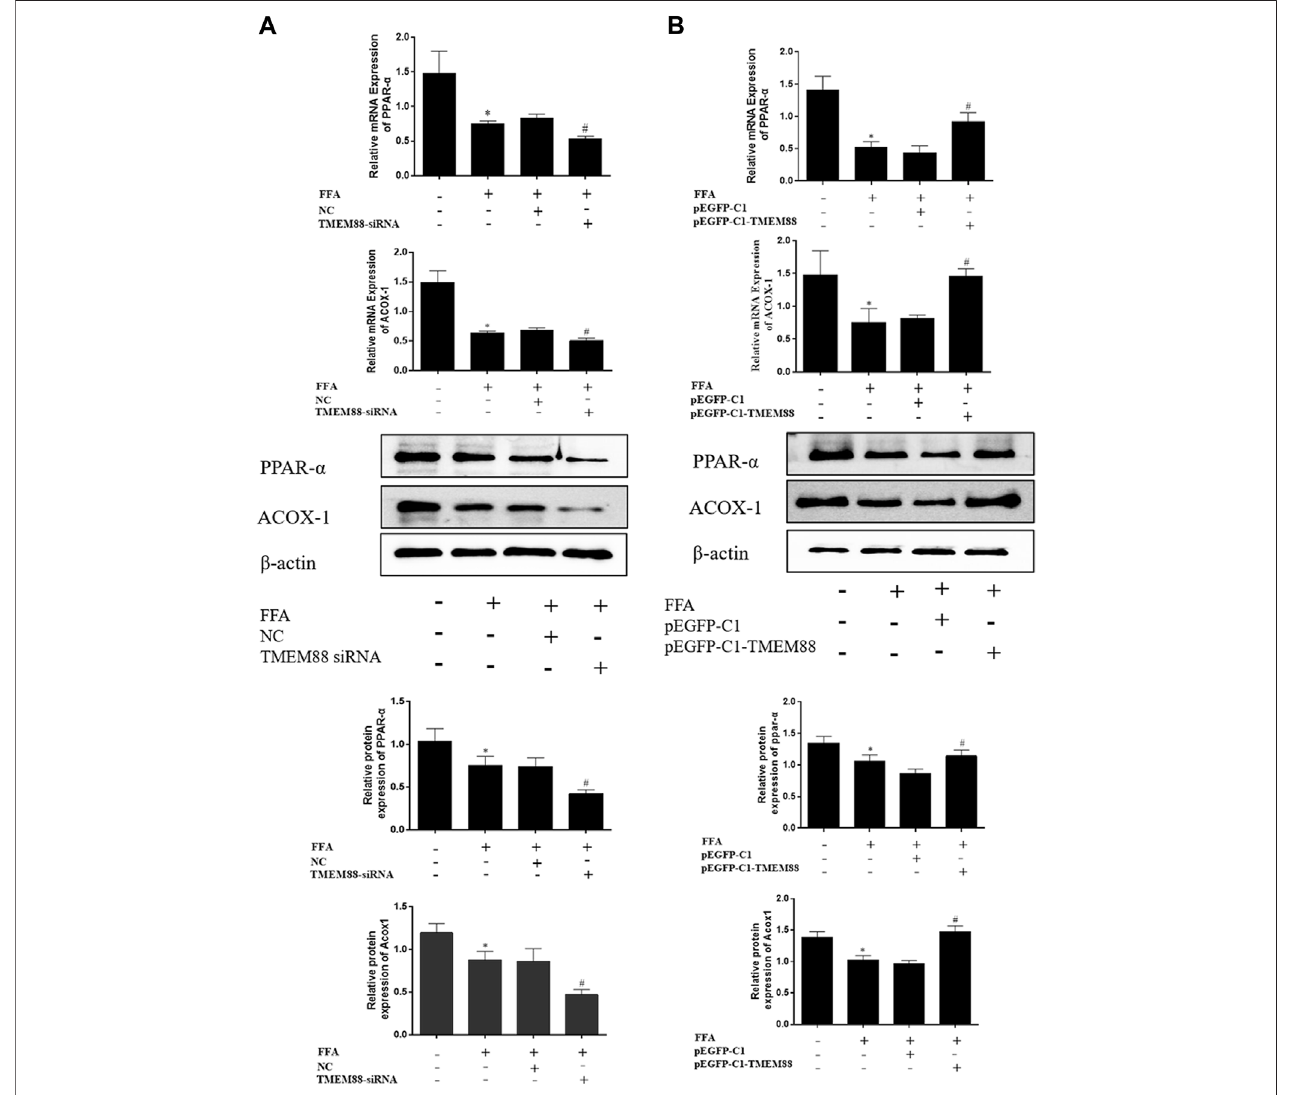
FIGURE5| SilencingoroverexpressionofTMEM88regulatedthelipidmetabolisminFFA-inducedAML-12cells. (A) TheresultsofRT-qPCRandWesternblotting showed that transfection of TMEM88 siRNA downregulated the expression levels of PPAR- α and ACOX-1. Conversely, (B) pEGFP-C1-TMEM88 upregulated the expression levels of PPAR- α and ACOX-1. (The data are represented by at least three independent mean ± SD, * p < 0.05 vs normal group, # p < 0.05 vs control group).